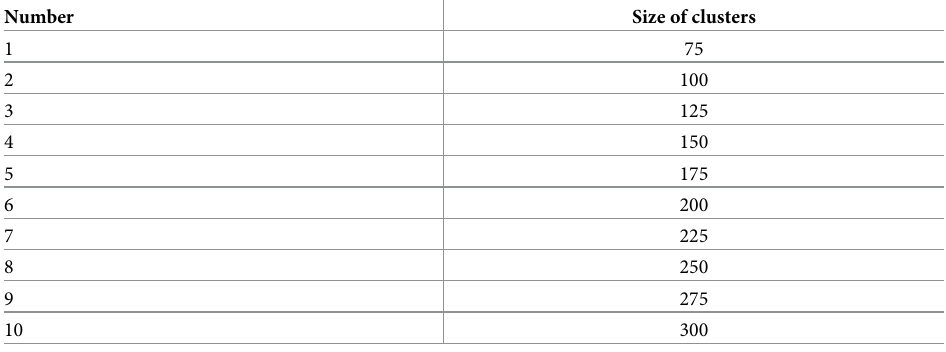
Table 7. Sum of squares method for hierarchical